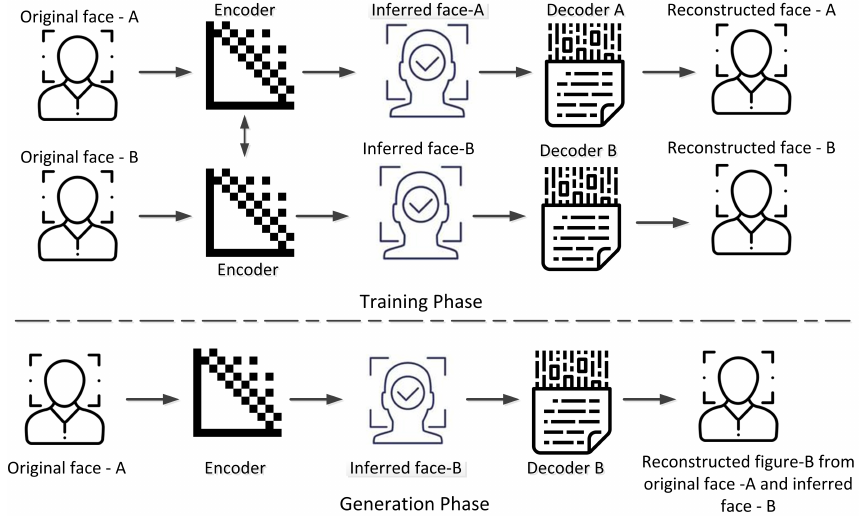
Figure 6. Simplified illustration of training and generating deepfake images or